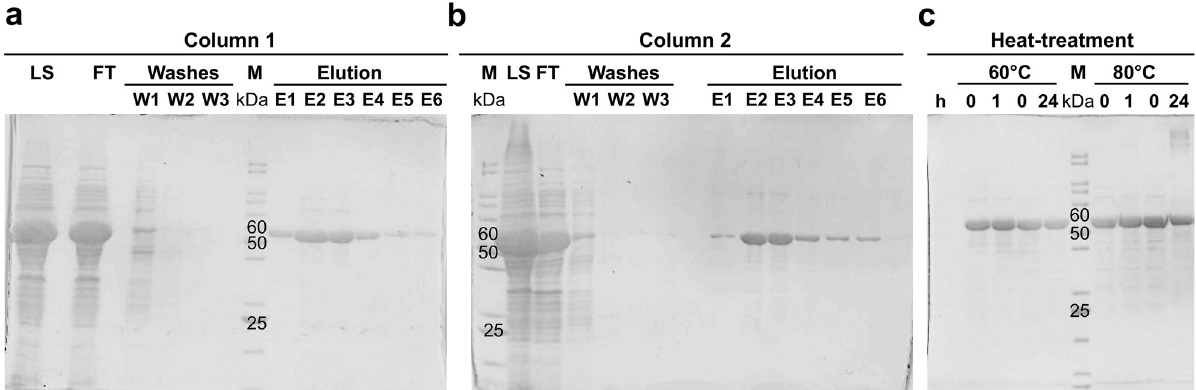
Figure 3. Ni-NTA purification of His-tagged TK AMPpase and its thermal stability. ( a , b ) 12% SDS- polyacrylamide gels showing the samples taken during the purification of TK AMPpase. Loaded sample (LS), flowthrough (FT), wash fractions (W1, W2, W3) and elution fractions (E1–E6). The FT from column 1 was loaded consecutively to column 2. ( c ) Heat treatment of the purified Tk AMPpase by incubation at 60 °C and 80 °C for 1 h and 24 h. A sample was taken before incubation (0